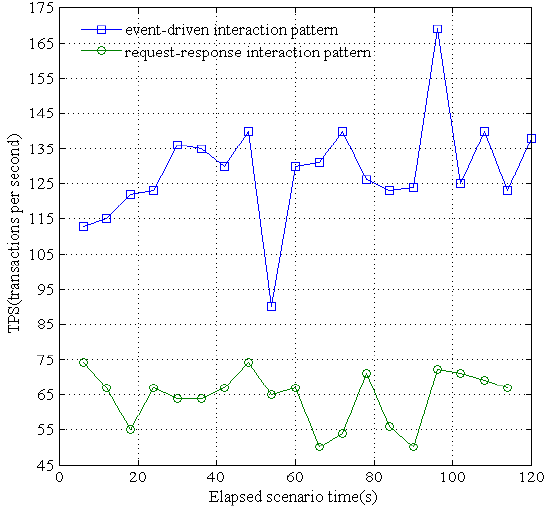
Figure 17. Transactions processed per second of event-driven and request-response.